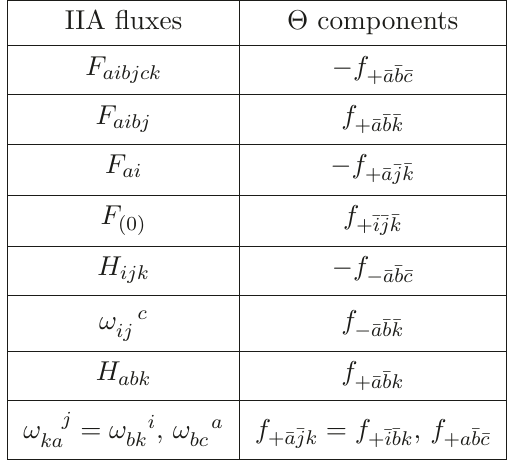
Table 5 . The embedding tensor/fluxes dictionary for the case of massive type IIA reductions on a twisted T 6 with gauge fluxes. The SO(6 , 6) index M is further split into its light-cone directions ( a, i, ¯ a, ¯ i ). Adapted from